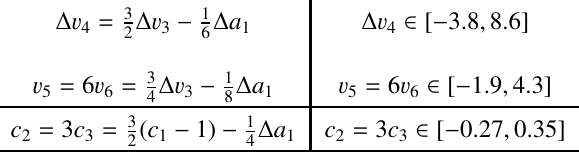
c c a 2 and 3 by 1 and 1 (from the correction to the value of the ∈ [0 . 84 , 1 . 22] c 1